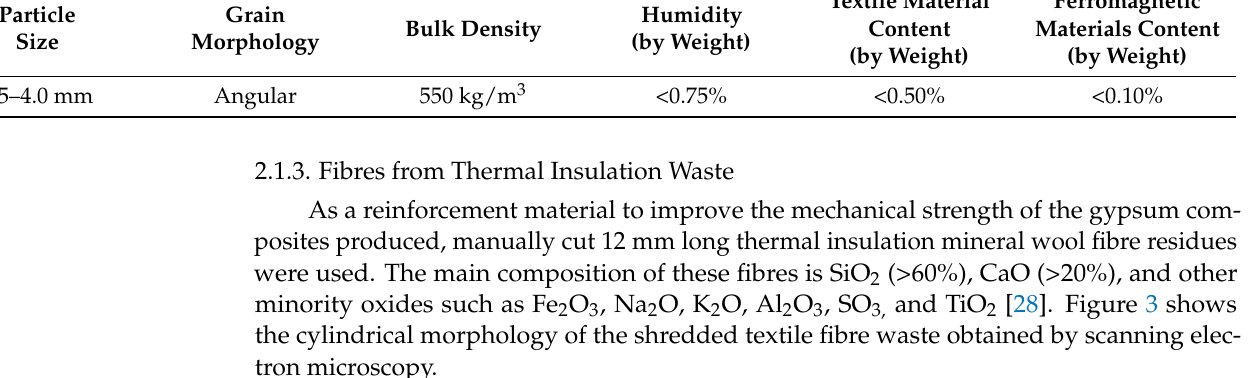
Table 1. Physical properties of fine gypsum YF-B1. Source: Saint-Gobain Placo.